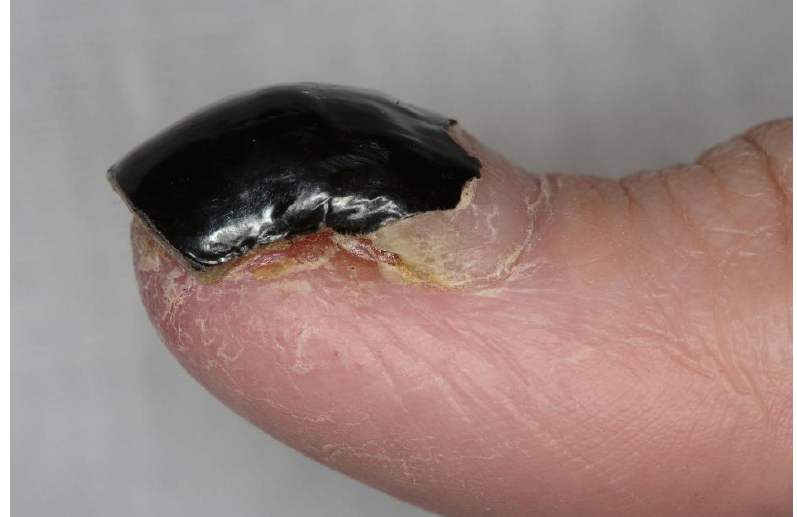
Figure 2. Paronychia in a patient on futibatinib (patient consent obtained).